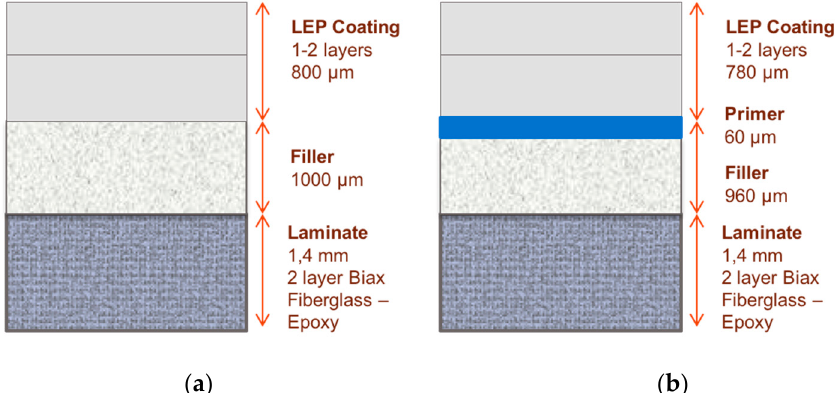
Figure 23. ( a ) Leading edge protection coating with an intermediate filler layer; ( b ) additional primer layer included to improve adhesion to the substrate.